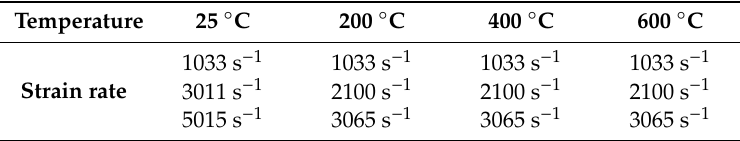
Table 3. Split Hopkinson compression bar (SHPB) experimental scheme.